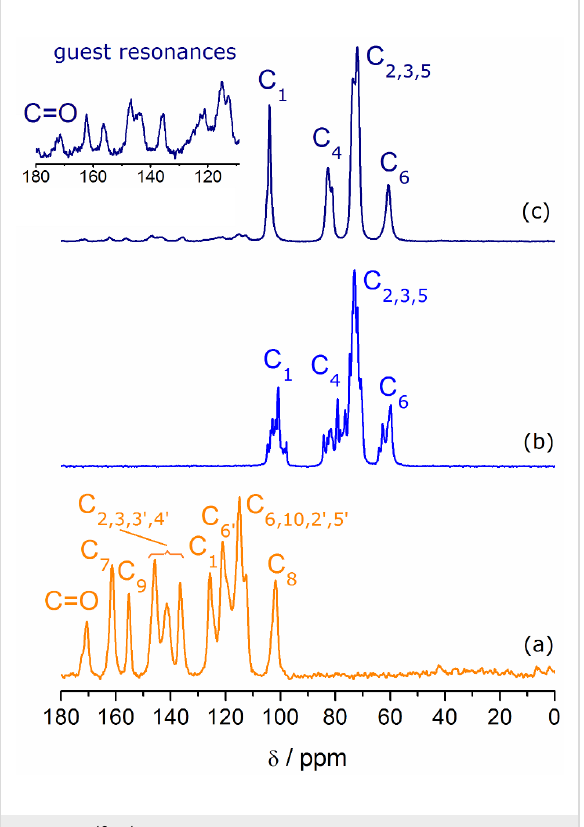
Figure 2: 13 C{ 1 H} CP/MAS NMR spectra for (a) fisetin, (b) γ -CD host, and (c) γ -CD·fisetin. The inset shows an expansion of the 180–110 ppm region for the spectrum of γ -CD·fisetin, in which the resonances of the guest are observed.